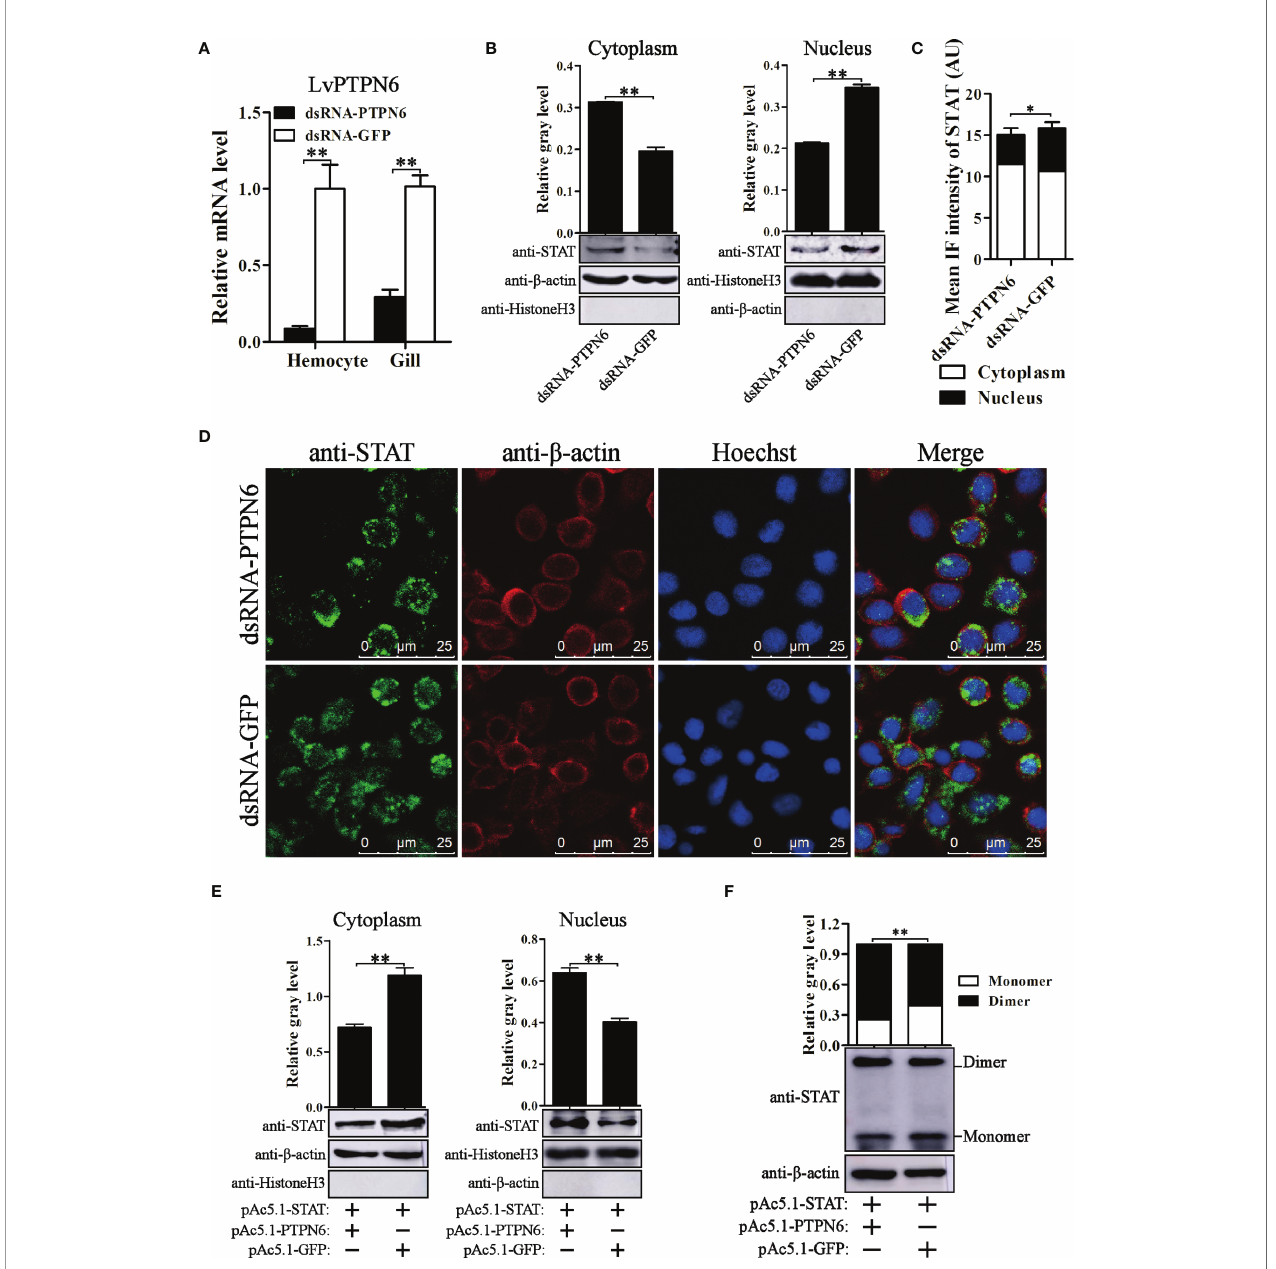
FIGURE 7 | Nuclear localization of STAT regulated by LvPTPN6. (A) qRT-PCR analysis of the LvPTPN6 mRNA level in hemocyte and gill at 48 h post dsRNA injection. Values in the dsRNA-GFP control group were set as the baseline (1.0). Each bar represents the mean ± SD ( n = 4), ** p < 0.01 by two-tailed unpaired Student ’ s t -test. (B) Western blot analysis of the protein level of STAT located in the cytoplasm and nucleus of hemocytes after dsRNA injection. (C) Immuno fl uorescence intensities (arbitrary units, AU) of cytoplasm- and nuclear-localized STAT in dsNRA-GFP- and dsRNA-PTPN6-treated hemocytes. Immuno fl uorescence intensities were calculated using JACoP with an ImageJ plugin from four randomly selected microscopic vision fi elds ( Supplemental Figure 3 ). * p < 0.05 by two-tailed unpaired Student ’ s t -test. (D) Immuno fl uorescent analysis of STAT in hemocytes after dsRNA injection. STAT was stained with Alexa Fluor 488 (green), the cytomembranes were visualized by b -actin stain with Alexa Flour 594 (red), and the nuclei were stained with Hoechst 33342 (blue). (E) Western blot analysis of the protein level of shrimp STAT located in the cytoplasm and nucleus of S2 cells overexpressed with LvPTPN6 or GFP (negative control). (B, E) In cytoplasm, the gray values of STAT bands were normalized to those of the cytoplasmic internal control of b - actin, and Histone H3 was detected to verify no contamination of nuclear protein. In nucleus, the gray values of STAT bans were normalized to those of the nuclear internal control of Histone H3, and b -actin was detected to verify no contamination of cytoplasmic protein. (F) Western blot analysis of the dimer and monomer levels of STAT through native PAGE after overexpressing LvPTPN6 in S2 cells. The gray values of STAT bans were normalized to those of the internal control of b -actin. (B – F) Each bar is mean ± SD of three independent quanti fi cation of the electrophoretic bands, ** p < 0.01 by two-tailed unpaired Student ’ s t